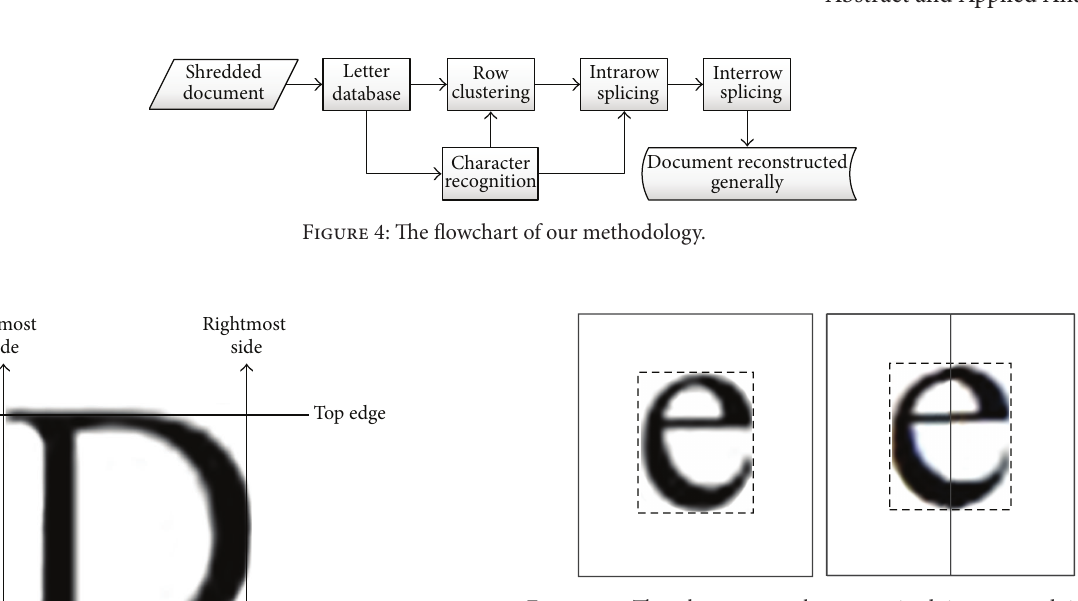
Figure 7: The character to be recognized is extracted in the rectangle.